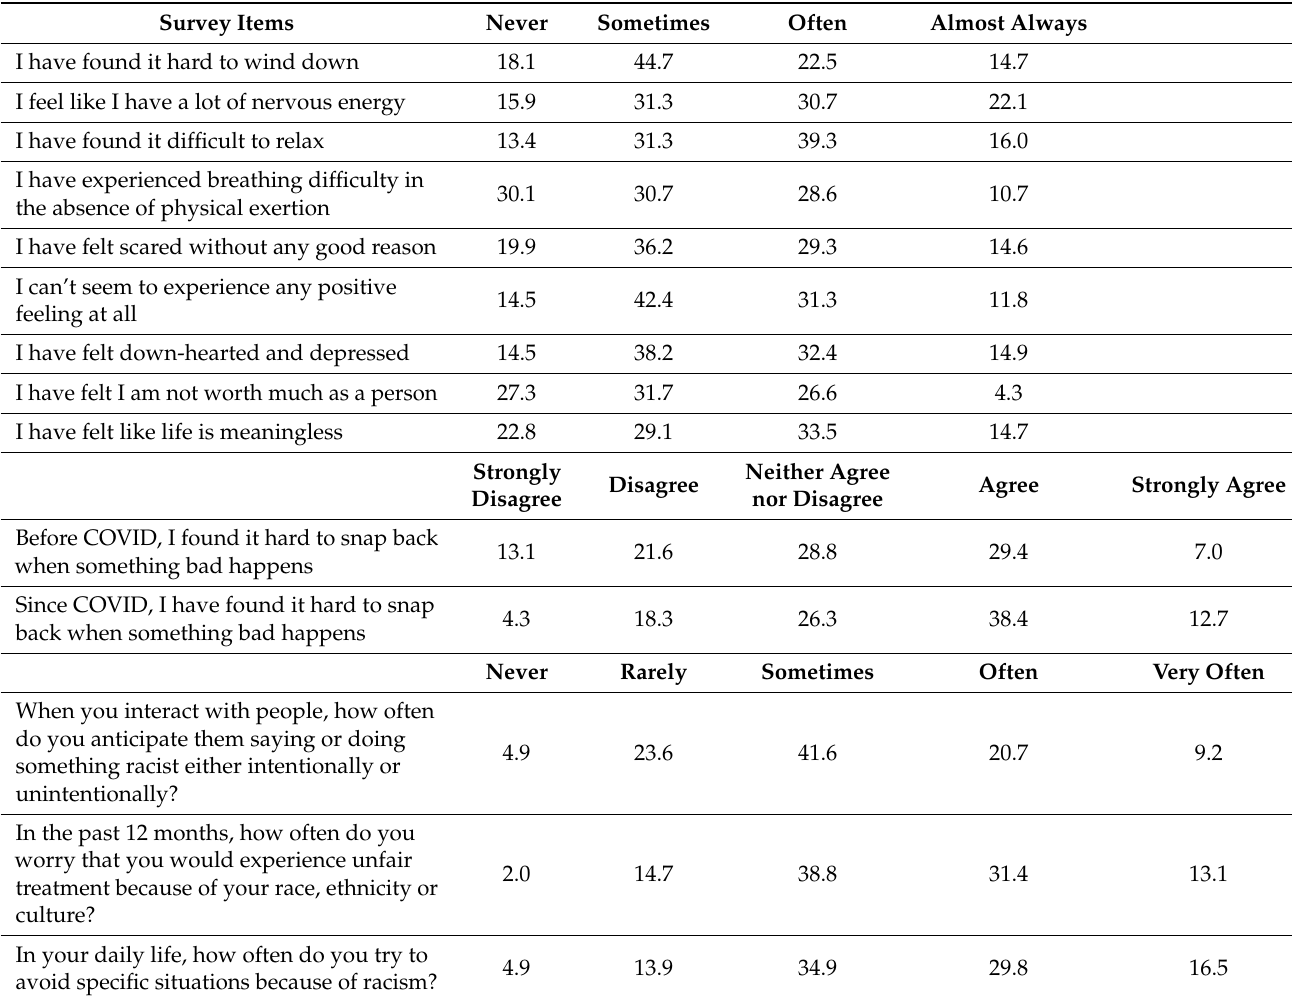
Table 3. Mental health and wellbeing for Asian Australians who experienced online racism during the COVID-19 pandemic (%), n =